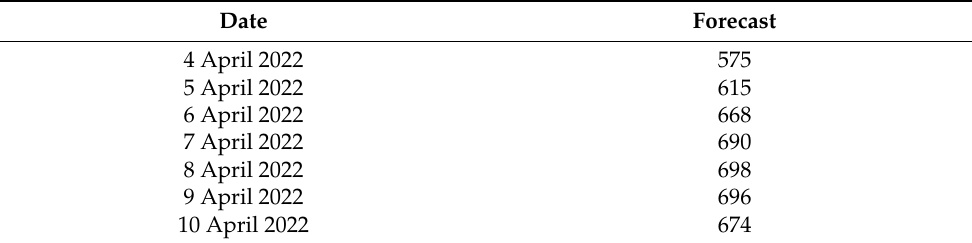
Table 2. Forecasting Results of Daily Confirmation Positive Cases using NNAR (27,28,1).